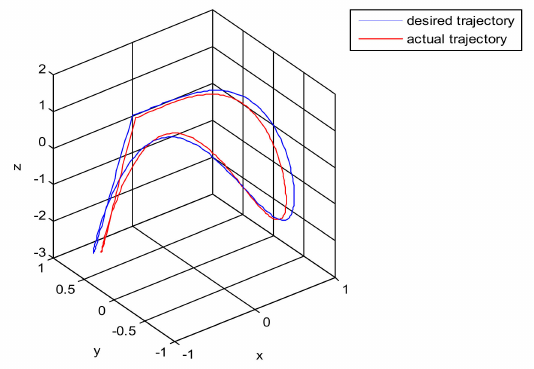
Figure 10. The trajectory tracking of end effector of Baxter right